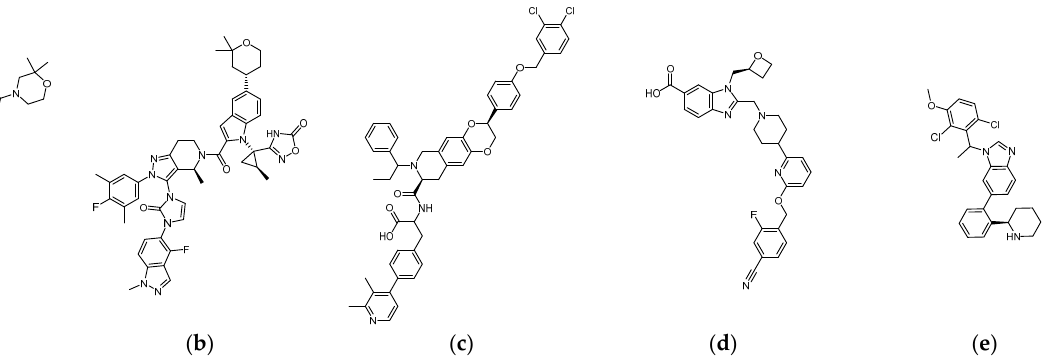
Figure 2. ( a ) UK1 (PDB:6X19; MW: 886 g/mol), ( b ) LY3502970 or V6G, OWL-833 (PDB:6XOX; MW: 883.0 g/mol), ( c ) TT-OAD2 (PDB:6ORV; MW: 929.7 g/mol), ( d ) PF-06882961 or UK4 (PDB:6X1A; MW: 555.6 g/mol), ( e ) LSN3160440 or QW7 (PDB:6VCB; MW: 480.43 g/mol) .